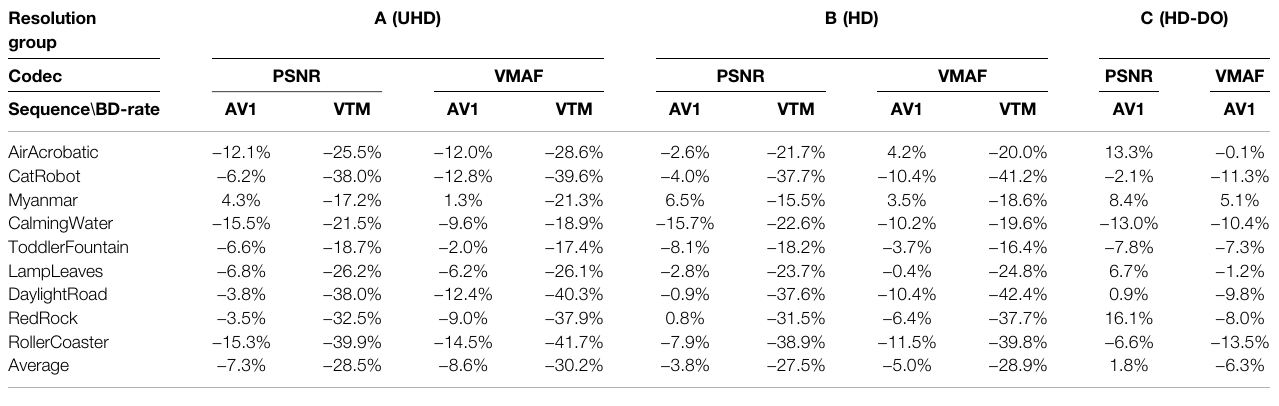
TABLE 5| Codec comparison resultsbasedonPSNR and VMAF quality metrics.Here Bjøntegaard DeltaBjøntegaard(2001) measurements (BD-rate) wereemployed, and HEVC HM was used as benchmark. Resolution group